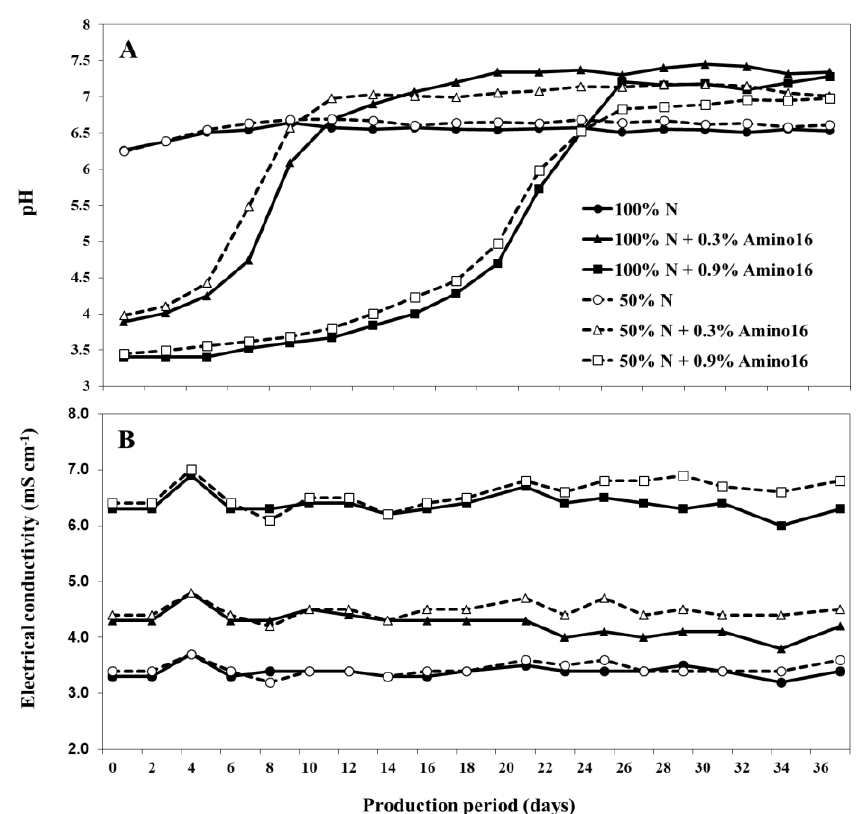
Figure 1. The pH ( A ) and the electrical conductivity ( B ) of the nutrient solutions supplied with 131 (100%) or 65.5 mg / L (50%) N and supplemented with 0, 0.3, or 0.9% Amino16 ® during growth of baby green and red loose-leaf lettuce. Table 1. Analysis of variance and mean comparison of plant weight and root length of green